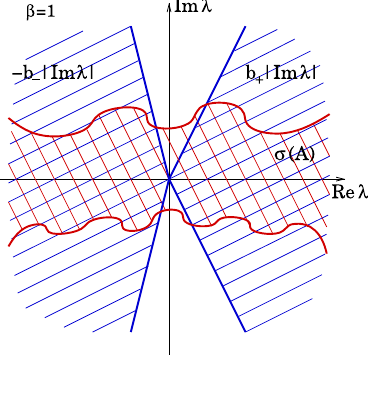
Figure 2: The case of β 1 =